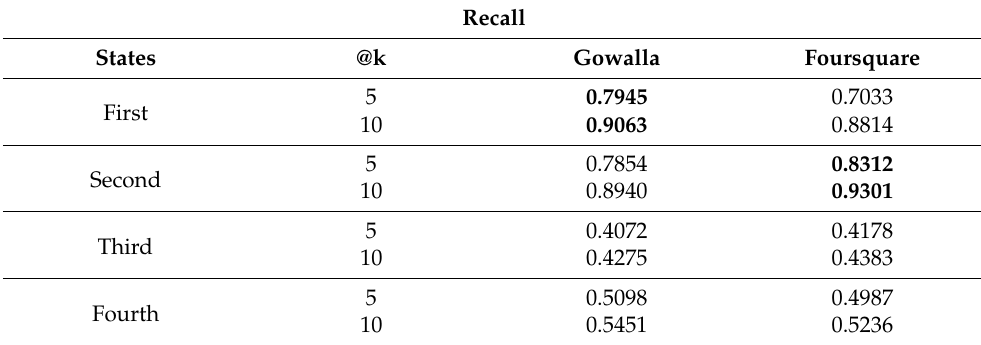
Table 4. A comparison among four sets of